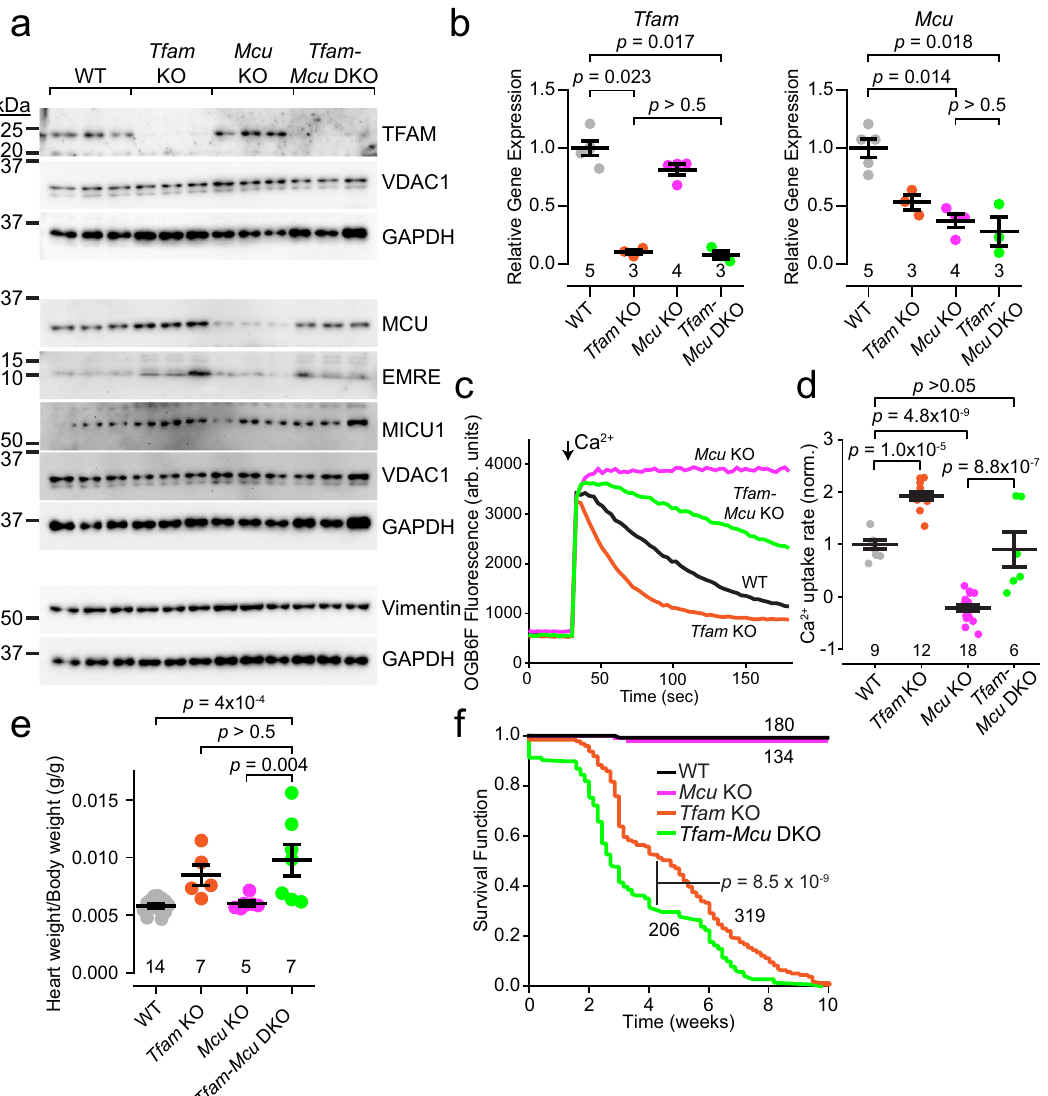
Fig. 5 Diminished MCU degradation is responsible for enhanced uniporter activity in Tfam KO hearts, and prolongs survival. a Immunoblotting for the speci fi ed proteins in P10-P14 mouse heart lysates. Samples from 3 mice shown per genotype. b Analysis of Tfam and Mcu transcripts in mouse hearts. c Ca 2 + uptake in isolated cardiac mitochondria incubated in Oregon Green BAPTA 6F (OGB6F). Arrow indicates 10 µ M Ca 2 + pulse. d Summary of the normalized rate of Ca 2 + uptake after a 10 µ M Ca 2 + pulse. e Heart weight to body weight ratios of P10-P14 mice of the indicated genotypes. f Kaplan – Meier survival analysis of the Tfam KO mice compared to Tfam-Mcu DKO mice. Comparison via a log rank test. Summary data are presented as mean values ± SEM. Statistics: ( b ) Kruskal – Wallis followed by Dunn ’ s test with Bonferroni correction; ( d , e ) 1-way ANOVA followed by Bonferroni-corrected means comparisons; ( f ) Log-rank test. Source data are provided as a Source Data fi